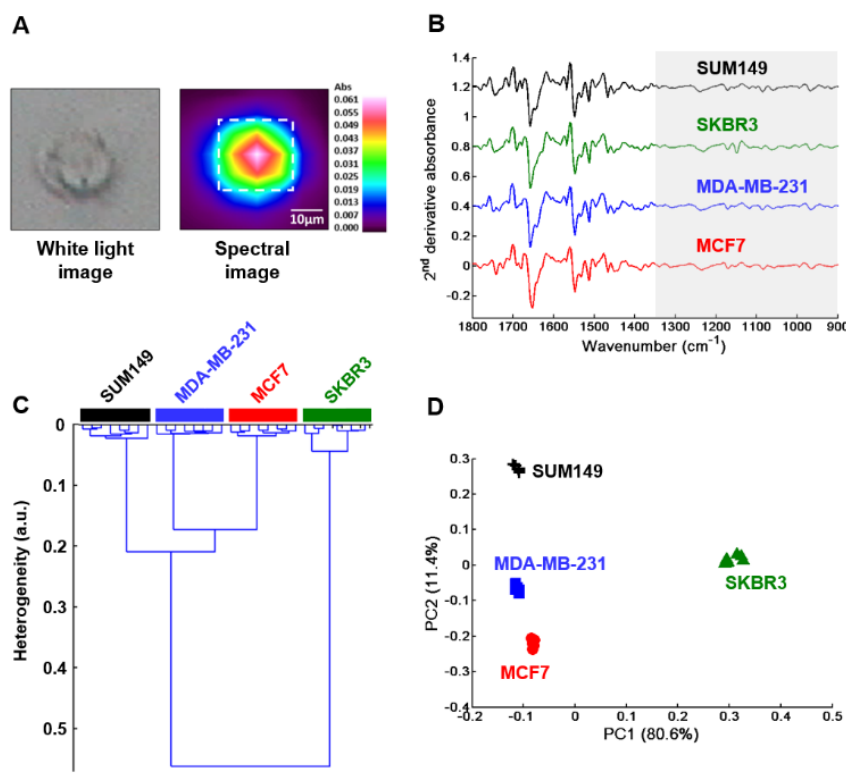
Figure 4. FTIR imaging of MCF7, MDA-MB-231, SKBR3 and SUM149 fixed single cells. ( A ) Illustration of a white light image of MCF7 single fixed cell (left) and its corresponding FTIR image (right). Scale bar: 10 µm; ( B ) Normalized second derivative of mean spectrum (n = 10) of each cell type. Spectra are offset for clarity; ( C ) HCA analysis and ( D ) PCA score plot of MCF7 (full red circles), MDA-MB-231 (full blue squares), SKBR3 (full green triangles) and SUM149 (black crosses). Both analyses were performed on normalized mean second derivative spectra using frequency range 1350–900 cm − 1 .